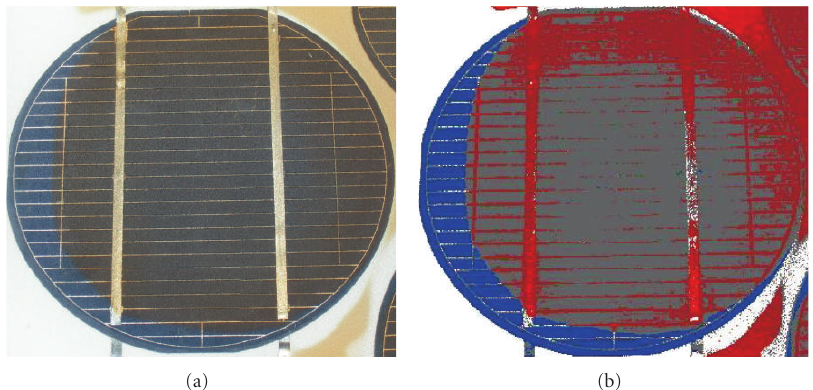
Figure 12: (a) Original digital image of a c-Si BP B1233 cell, (b) respective pseudocolour image provided by the proposed segmentation algorithm.